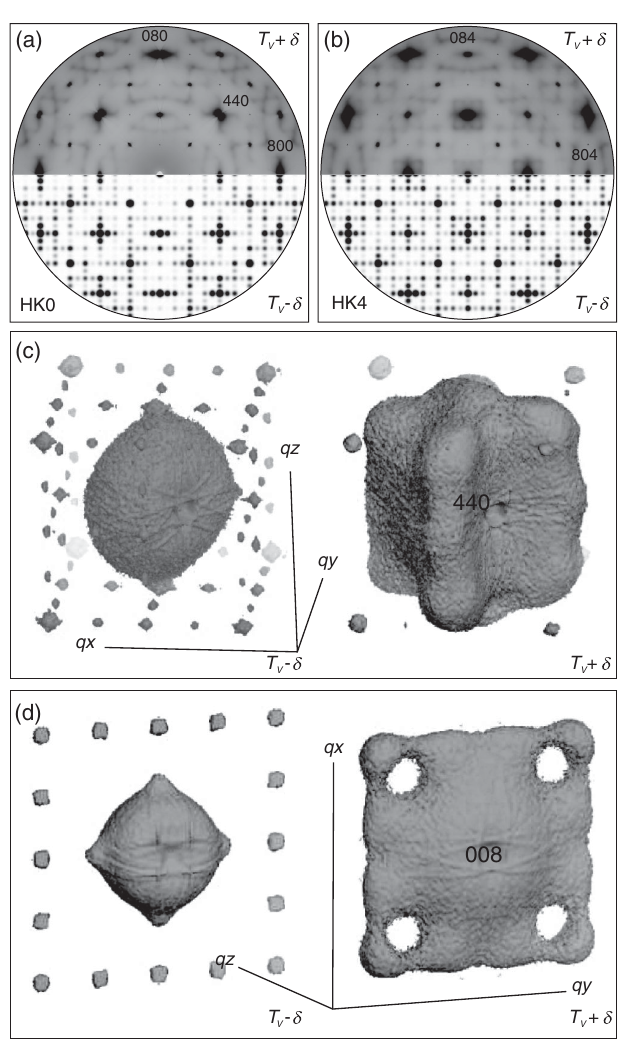
FIG. 3. Top: Similarity of scattered intensity distribution in magnetite above and below the Verwey transition. Magnetite reciprocal space cuts, (a) HK0 and (b) HK4, are compared for þ δ , upper part) and below T temperatures above T ( T V V V − δ , lower part), with δ ∼ 2 . 5 K. Gaussian blurring is applied ( T V to the superstructure reflections; main reflections are replaced by constant intensity peaks to avoid masking the superstructure- FIG. 4. Temperature dependence of characteristic diffuse in- related features. Middle and bottom panels: Isosurface represen- tensity in magnetite: (a) linear scans across the arclike diffuse tation of diffuse scattering in magnetite as given in the proximity feature of magnetite for temperatures between T of the (c) (440) and (d) (008) node. Indices and vector lengths are temperature, and (b) the temperature decay of the derived 1 =w 3 given in r.l.u. of the cubic structure. Cubic m 3 m Laue symmetry value (symbols), together with its exponential fit A exp ð − T= τ Þ is applied. Artificial twinning of the low-temperature data (solid line). Here, w is the width of the linear diffuse scattering recovers the cubic symmetry. scans and a 0 denotes the lattice parameter of the cubic